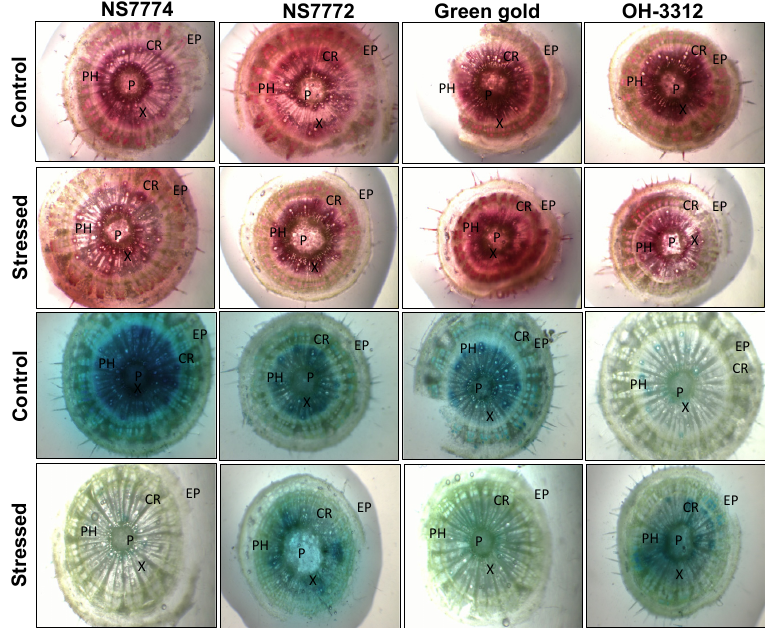
Figure 6. Vascular transport, as affected by drought stress at 5 and 10 days of interval in okra genotypes NS7774, NS7772, Green Gold, and OH3312, along with respective controls. Red and blue food-coloring dyes were used for the absorption process, indicating activity of vascular tissue. EP indicates epidermis; CR indicates cortex; X indicates xylem; P indicates phloem.